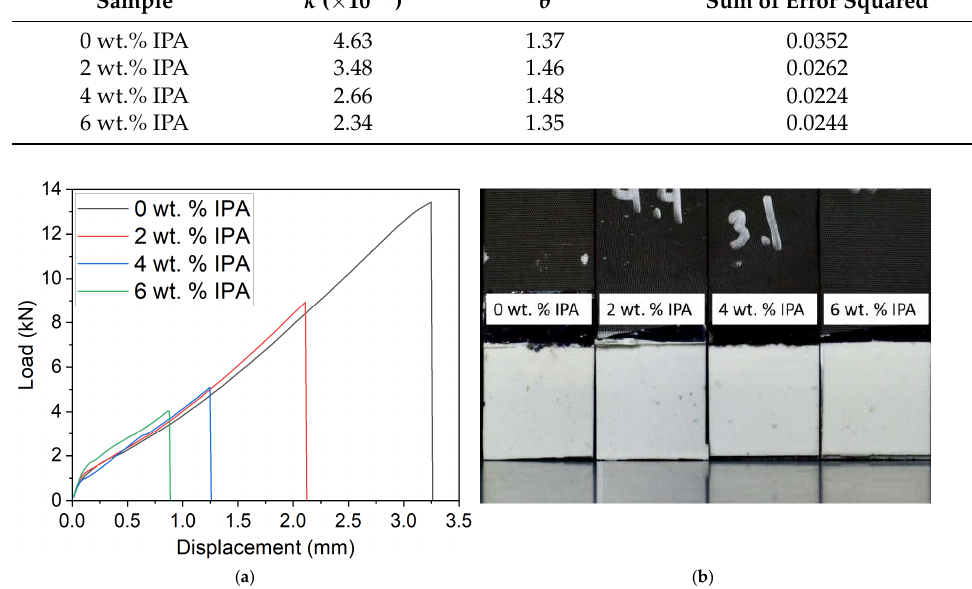
Table 2. Rate constant k and shape parameter θ of the Hill equation model for each sample type. Sample